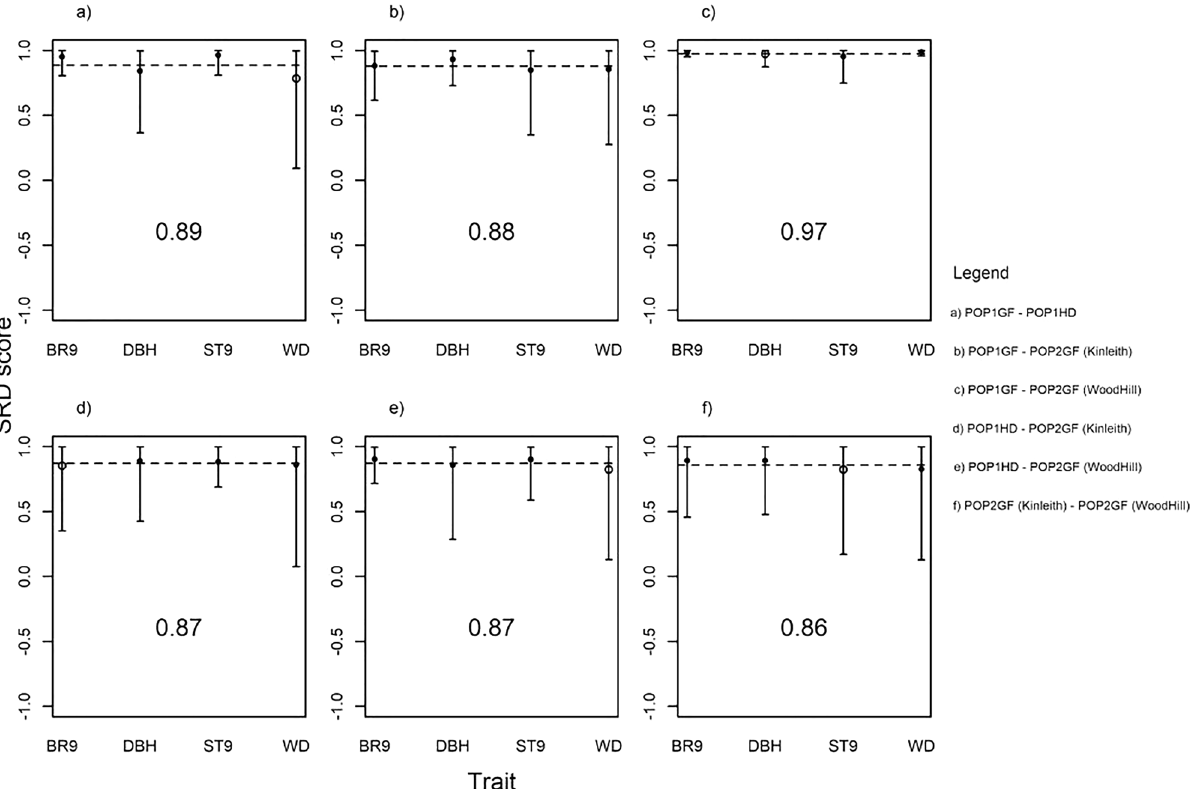
Figure 6. Selection response decomposition (SRD) score for the combination of each population sample under study: ( a ) POP1GF and POP1HD; ( b ) POP1GF and POP2GF at Kinleith; ( c ) POP1GF and POP2GF at Woodhill; ( d ) POP1HD and POP2GF at Kinleith; ( e ) POP1HD and POP2GF at Woodhill and ( f ) POP2GF at Kinleith and POP2GF at Woodhill. Mean is shown as a dotted line.